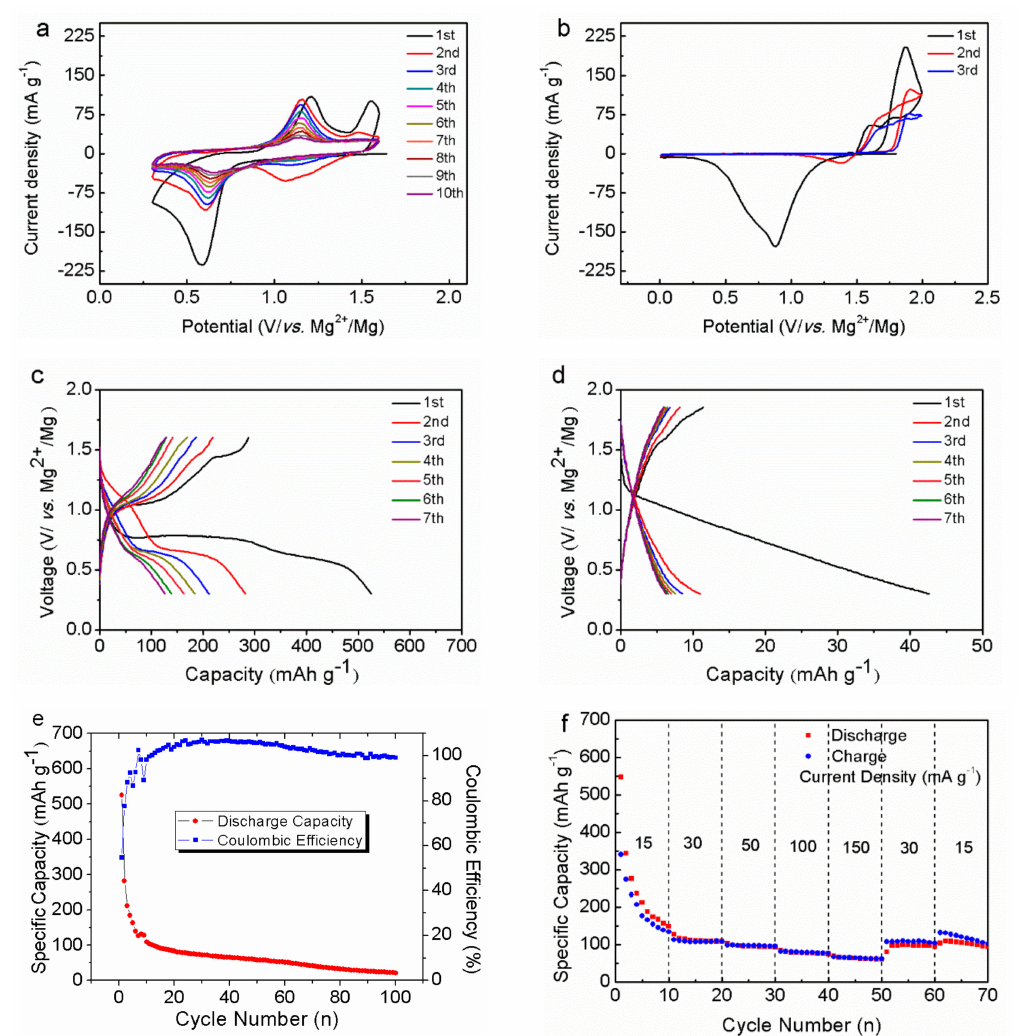
Figure 3. CV curves of ( a ) FeSe 2 | Mg 2 + / Li + | Mg cell and ( b ) FeSe 2 | Mg 2 + | Mg cell; charge–discharge curves of ( c ) FeSe 2 | Mg 2 + / Li + | Mg cell and ( d ) FeSe 2 | Mg 2 + | Mg cell; ( e ) cycling performance and Coulombic e ffi ciency of FeSe 2 | Mg 2 + / Li + | Mg cell; ( f ) rate capability of FeSe 2 | Mg 2 + / Li + | Mg